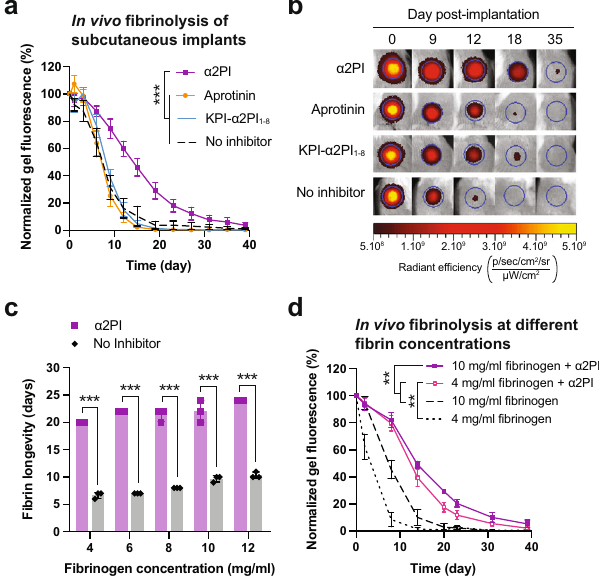
Fig. 2 In vivo ef fi cacy of α 2PI to protect fi brin biomaterials as compared to the clinical aprotinin and at low-concentration fi brin. a Degradation of fi brin gels containing 15 μ M of α 2PI, aprotinin, KPI- α 2PI 1 – 8 or no inhibitors when implanted subcuta- neously in the back of mice ( n = 5 gels/group). Fibrin degradation was monitored via fl uorescence reduction quanti fi ed by IVIS imaging. b Representative images of the degradation of the subcutaneous fi brin implants, as presented in a . c In vitro longevity of fi brin gel supplemented with α 2PI (1 μ M) or without inhibitor according to the concentration of fi brinogen when incubated with 2.5 nM plasmin. Mean ± SD. Statistical comparison was done using Student ’ s t-test. d In vivo degradation of fi brin gels made of 4 mg/ mL or 10 mg/mL of fi brinogen containing 15 μ M α 2PI or no inhibitor, when implanted subcutaneously in the back of mice ( n = 5 gels/ group). Mean ± standard error of the mean (SEM) if not stated otherwise. Statistical comparisons were done using ANOVA test